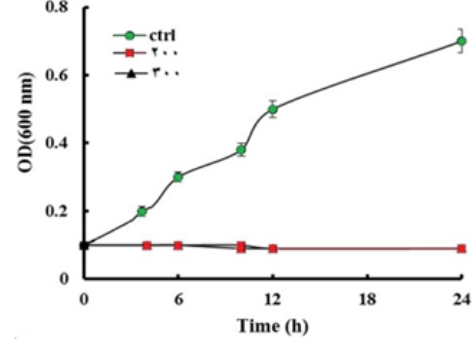
Fig. 5. Antibacterial activity of silver nanoparticles against Fig. 6. The growth pattern of Escherichia coli in the presence Fig5. Antibacterial activity of silver nanoparticles against Pseudomonas aeruginosa Fig6 . The growth pattern of Escherichia coli in the presence and absence of silver nanoparticles Pseudomonas aeruginosa and absence of silver nanoparticles (concentrations in μg / (concentrations in μ g / ml)